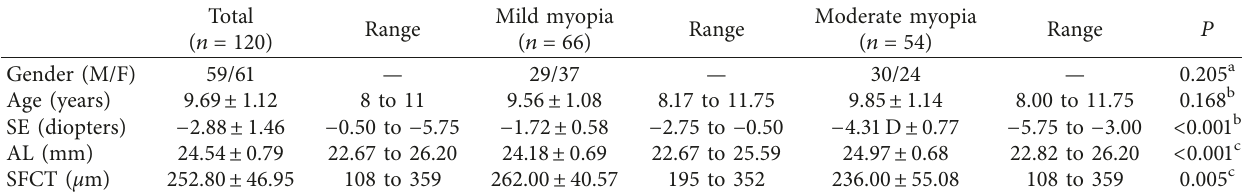
Table 1: General characteristics of the 120 participants and comparison between different refraction